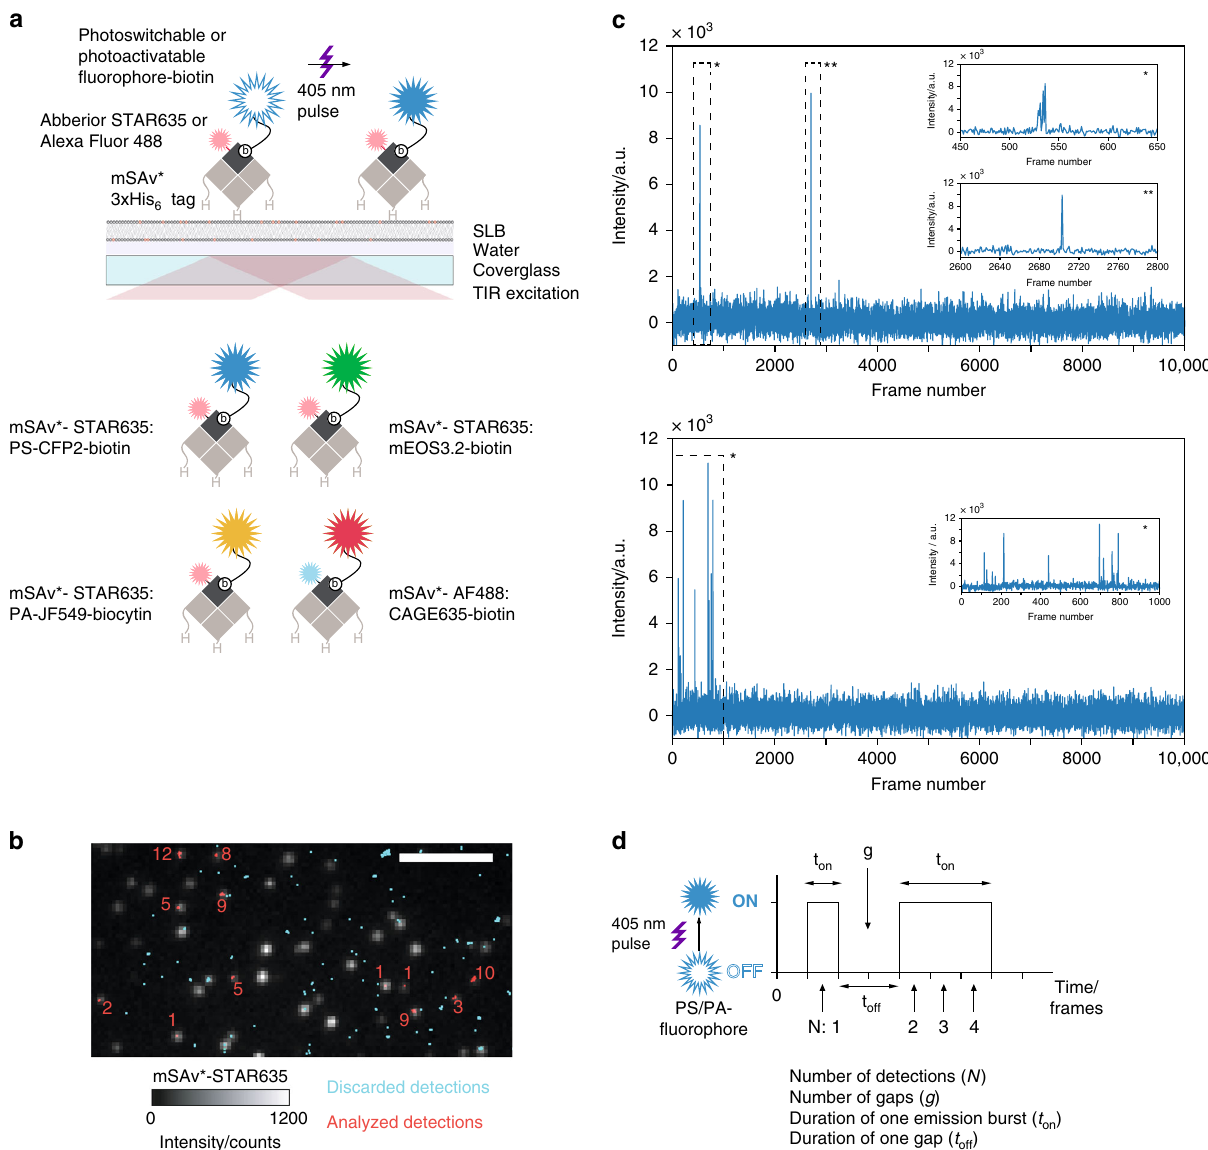
Fig. 1 Imaging platform to quantitate blinking parameters of recombinant photoswitchable (PS) or photoactivatable (PA) fl uorophores. a PS/PA fl uorophore-mSAv*-STAR635 (or-AF488) conjugates were anchored to immobile SLBs containing 99.5% DPPC and 0.5% DGS-NTA(Ni). PS/PA fl uorophores were identi fi ed by means of co-localization with mSAv* site-speci fi cally conjugated to STAR635 or-AF488, which allowed for precise acquisition of blink statistics in TIR mode on a single-molecule level (top). All four characterized PS/PA fl uorophores, i.e., PS-CFP2, mEOS3.2, PA-JF549, and CAGE635, are displayed together with their respective label used for co-localization analysis (bottom). b Two-color co-localization of STAR635 and PS-CFP2 enabled discrimination of false-positive detections as shown in the images acquired for mSAv*-STAR635 (monochrome color channel) and from consecutive PALM of single PS-CFP2 signals (red and cyan colored detections). The total number of PS-CFP2 detections per analyzed signal are indicated in red. Scale bar is 4 µ m. c Representative intensity traces acquired in 10,000 image frames for a single PS-CFP2 molecule exhibiting two bursts of detections (upper panel) and another exhibiting multiple burst (lower panel). Inserts provide a higher temporal resolution of indicated bursts. d Four parameters were extracted from single-molecule traces: (i) the total number of detections ( N ), (ii) the number of off-gaps ( g ) occurring within single traces, (iii) the duration of each emission burst ( t on ), and (iv) the duration of each off-gap ( t off Determining the blinking parameters of PS-CFP2, mEOS3.2, N , g , and t on can in principle be adequately accounted for by CAGE635, and PA-JF549 . We analyzed the temporal emission patterns of single PS-CFP2, mEOS3.2, PA-JF549, and CAGE635 molecules with regard to four parameters affecting the inter- pretation of localization maps (Fig. 1d): (i) the total number of detections per molecule within the whole imaging sequence ( N ), (ii) the number of gaps within a single PS or PA fl uorescent molecule trace ( g ), (iii) the duration of each emissive state ( t on ) and (iv) the duration of each gap ( t off ). Of note, high values in